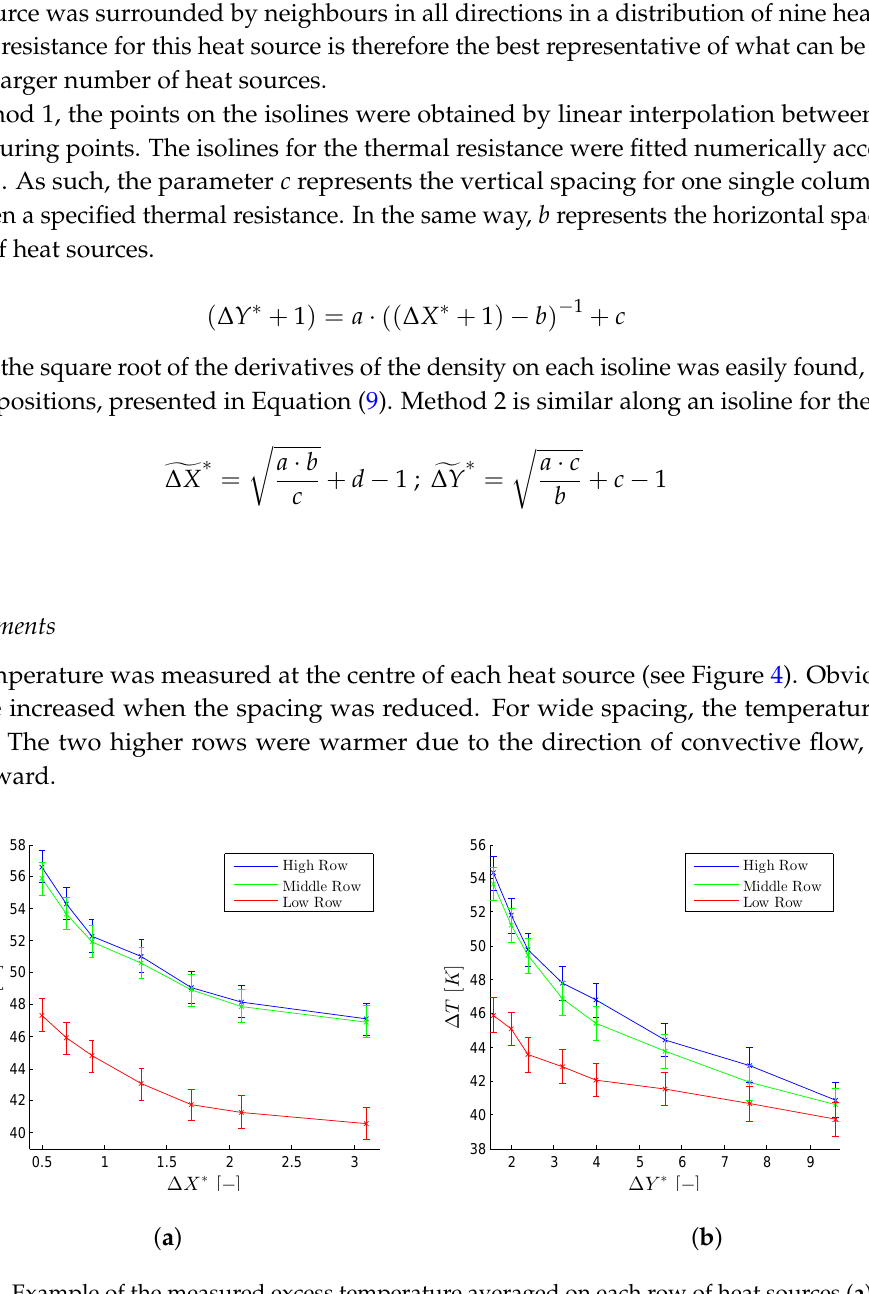
Figure 4. Example of the measured excess temperature averaged on each row of heat sources ( a ) as a function of the horizontal spacing for a fixed vertical one; and ( b ) as a function of the vertical spacing for a fixed horizontal